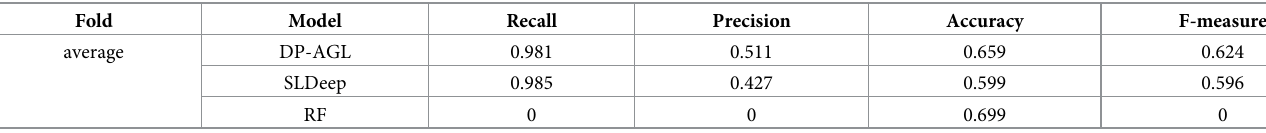
Table 5. Experimental results on training with accuracy neighborhood 2.